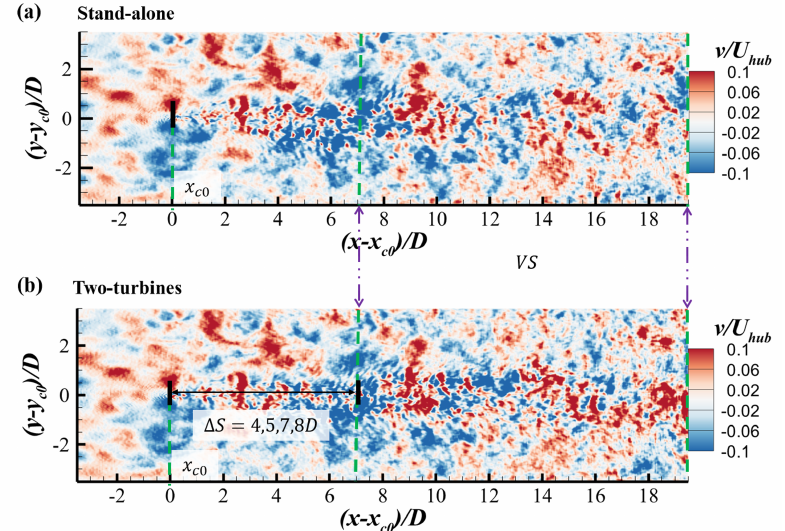
Figure 5. Contours of instantaneous spanwise velocity on the horizontal plane located at turbine hub height for ( a ) the stand-alone turbine case and ( b ) the two-turbine case with ∆ S / D = 4 for inflow1 with k 0 = 0.001